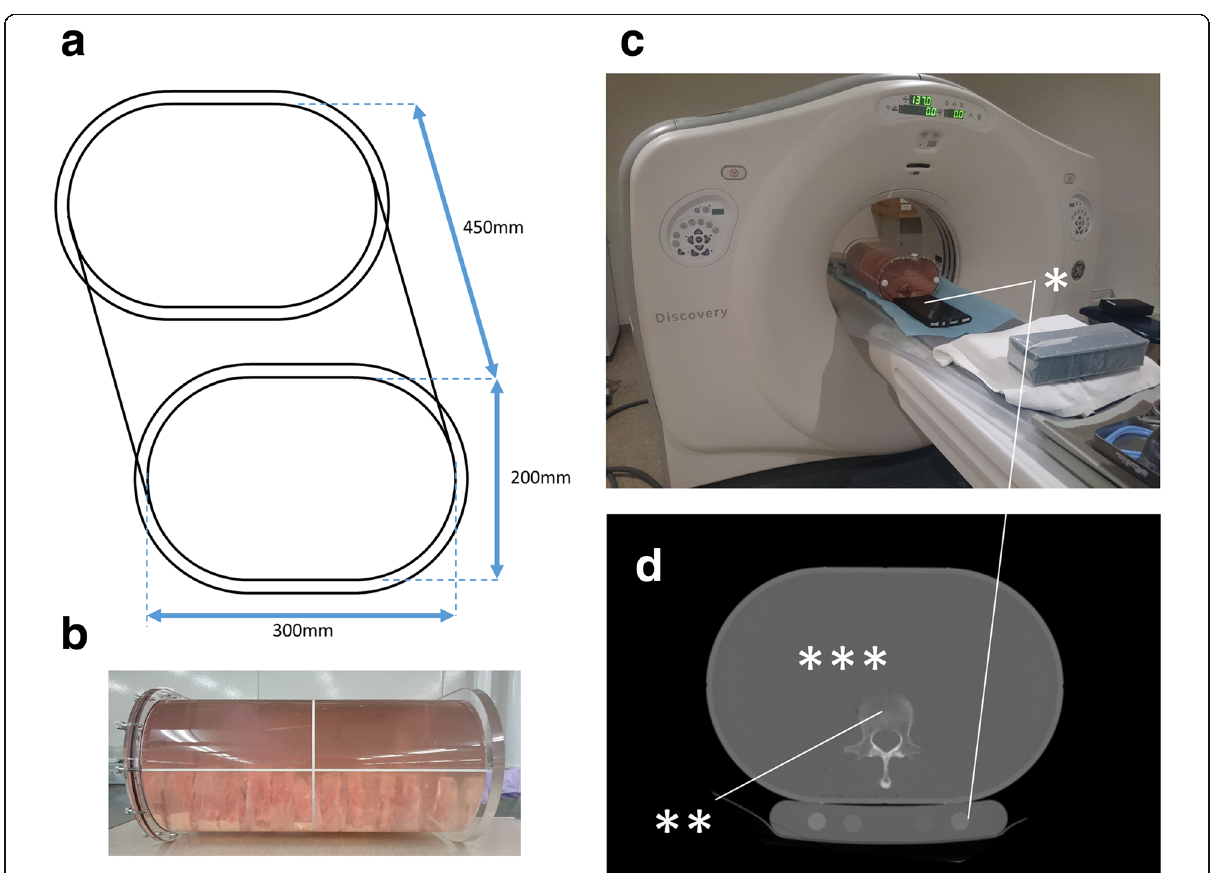
Fig. 1 Multislice computed tomography. a Drawing of the in-house round rectangle-shaped tank. b Vertebrae in the tank. c Photograph of the tank and the phantom (*) in the scanner. d Axial image showing the phantom (*), one vertebra (**), and the surrounding water for mimicking a living body